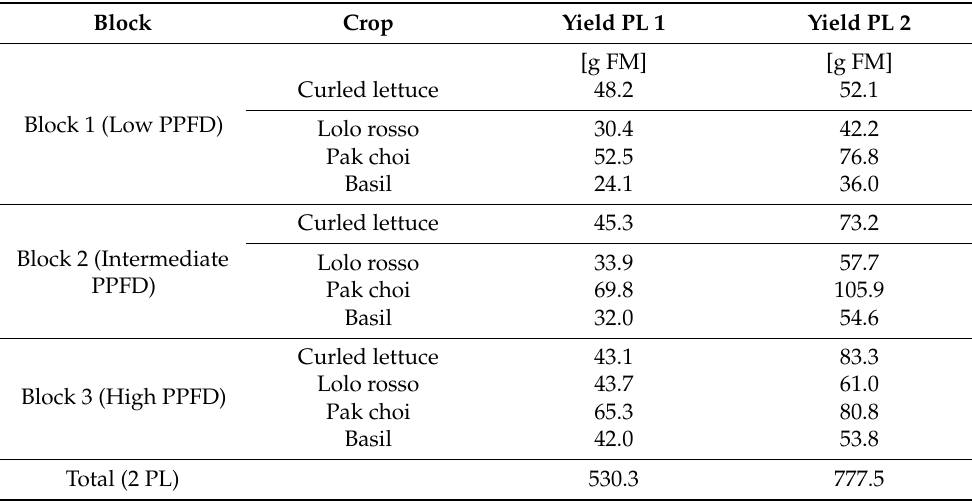
Table 8. Yield per PL and PPFD